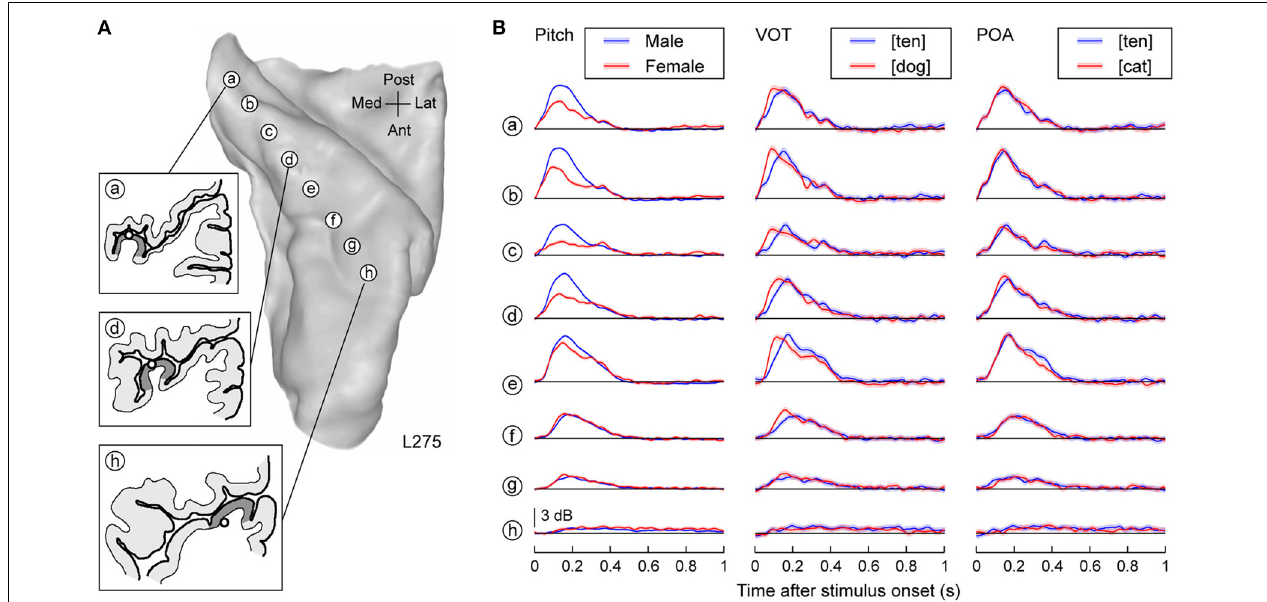
FIGURE 1 | Representation of acoustic stimulus attributes in HG. (A) MRI of left superior temporal plane in subject L275 showing the locations of recording contacts chronically implanted in HG. Insets: tracings of MRI cross-sectionsshowingthelocationofthreerecordingcontacts(circles)relative